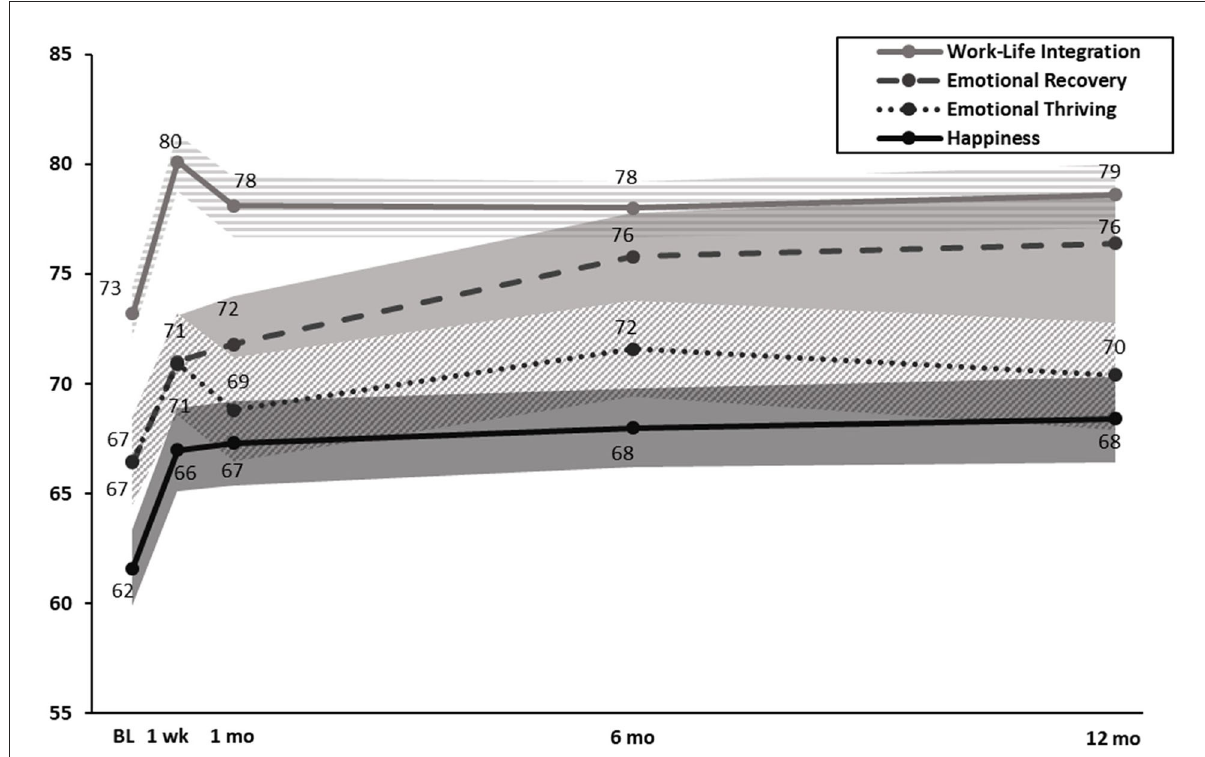
FIGURE3 Effect of WISER for work-life integration, emotional recovery, emotional thriving, and happiness at 1-week, 1-, 6-, and 12-month post-intervention (100-point scale). Note: Dots in the middle line: point estimates from mixed-effects models for each time point; shaded areas: 95% confidence intervals from mixed-effects models. BL, baseline; 1 wk, 1-week post-intervention; 1 mo, 1-month post-intervention; 6 mo, 6-month post-intervention; 12 mo, 12-month